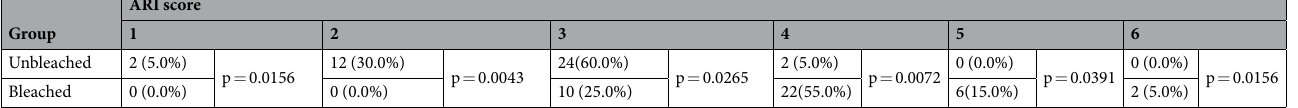
Table 1. The distribution and frequency of the adhesive remnant index (ARI) scores in bleached and unbleached group (p ≤